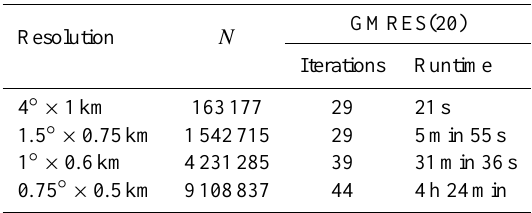
Table 4. Runtime results for the WACCM conductivity with clouds on a MacBook Pro 2.7GHz Intel Core